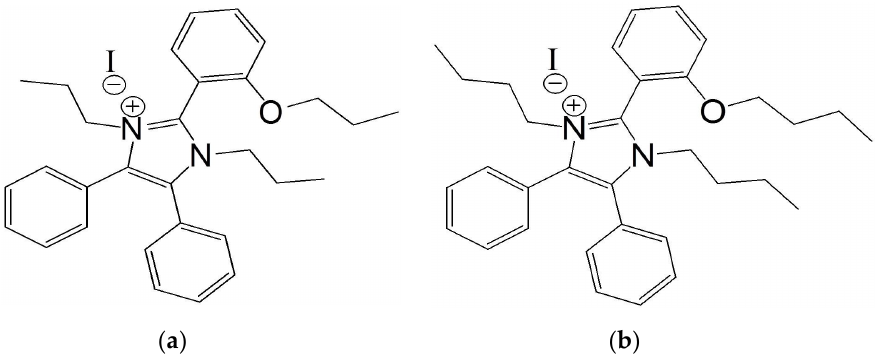
Figure 1. Chemical structures of new ionic liquids (ILs): ( a ) IL1; ( b ) IL2.